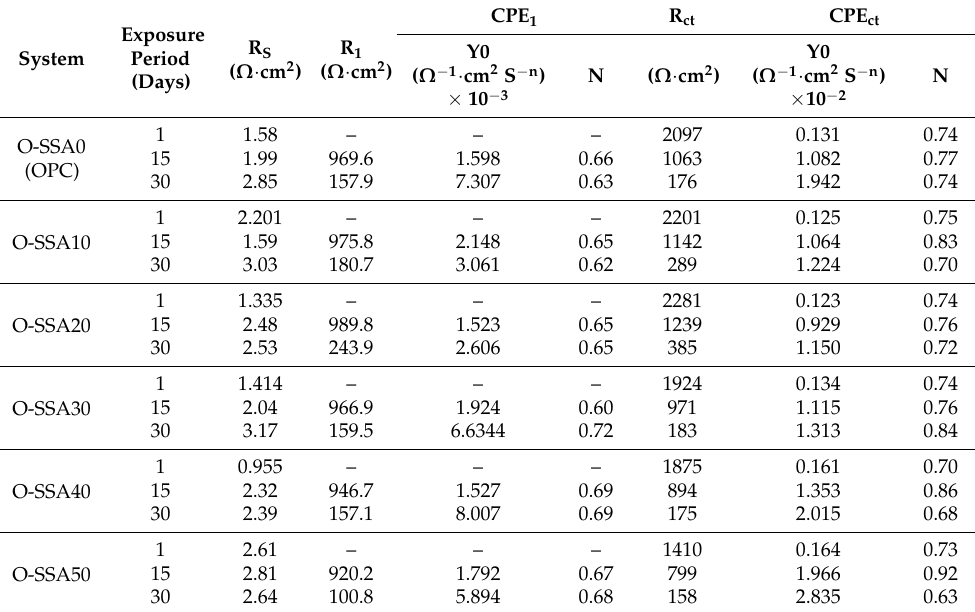
Figure 8. EIS-Nyquist plots for steel rebars in various cement extracts for an exposure period of 1 day ( a ); 15 days ( b ); and 30 days ( c ). Table 5. Impedance parameters for steel rebars in various cement extracts for various exposure periods obtained from Nyquist